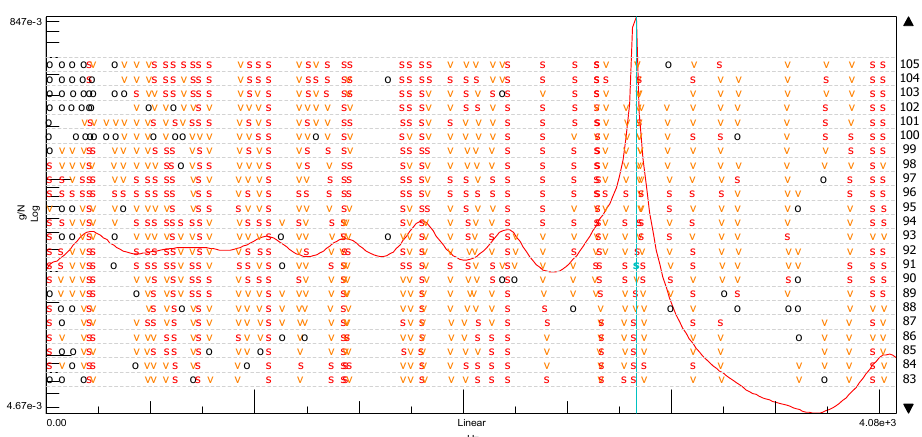
Figure 16. Spectral function of the FRF transition for the ordinary concrete cube with the first natural frequency marked.